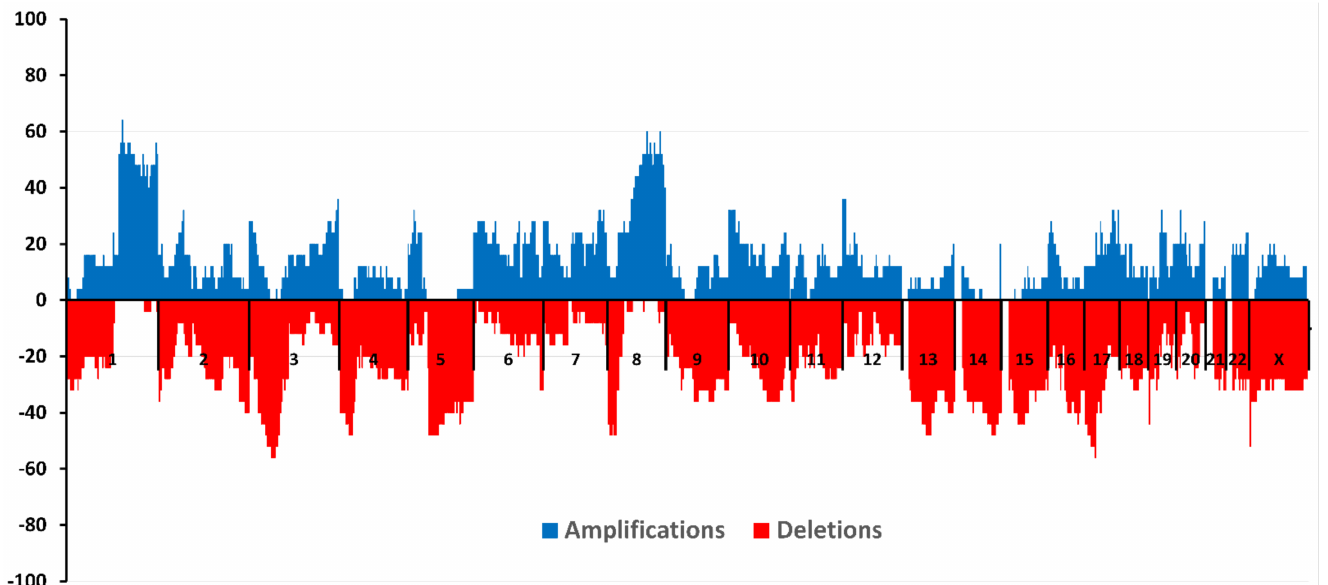
Figure 3. Frequencies of deletions and amplifications in triple-negative breast cancer